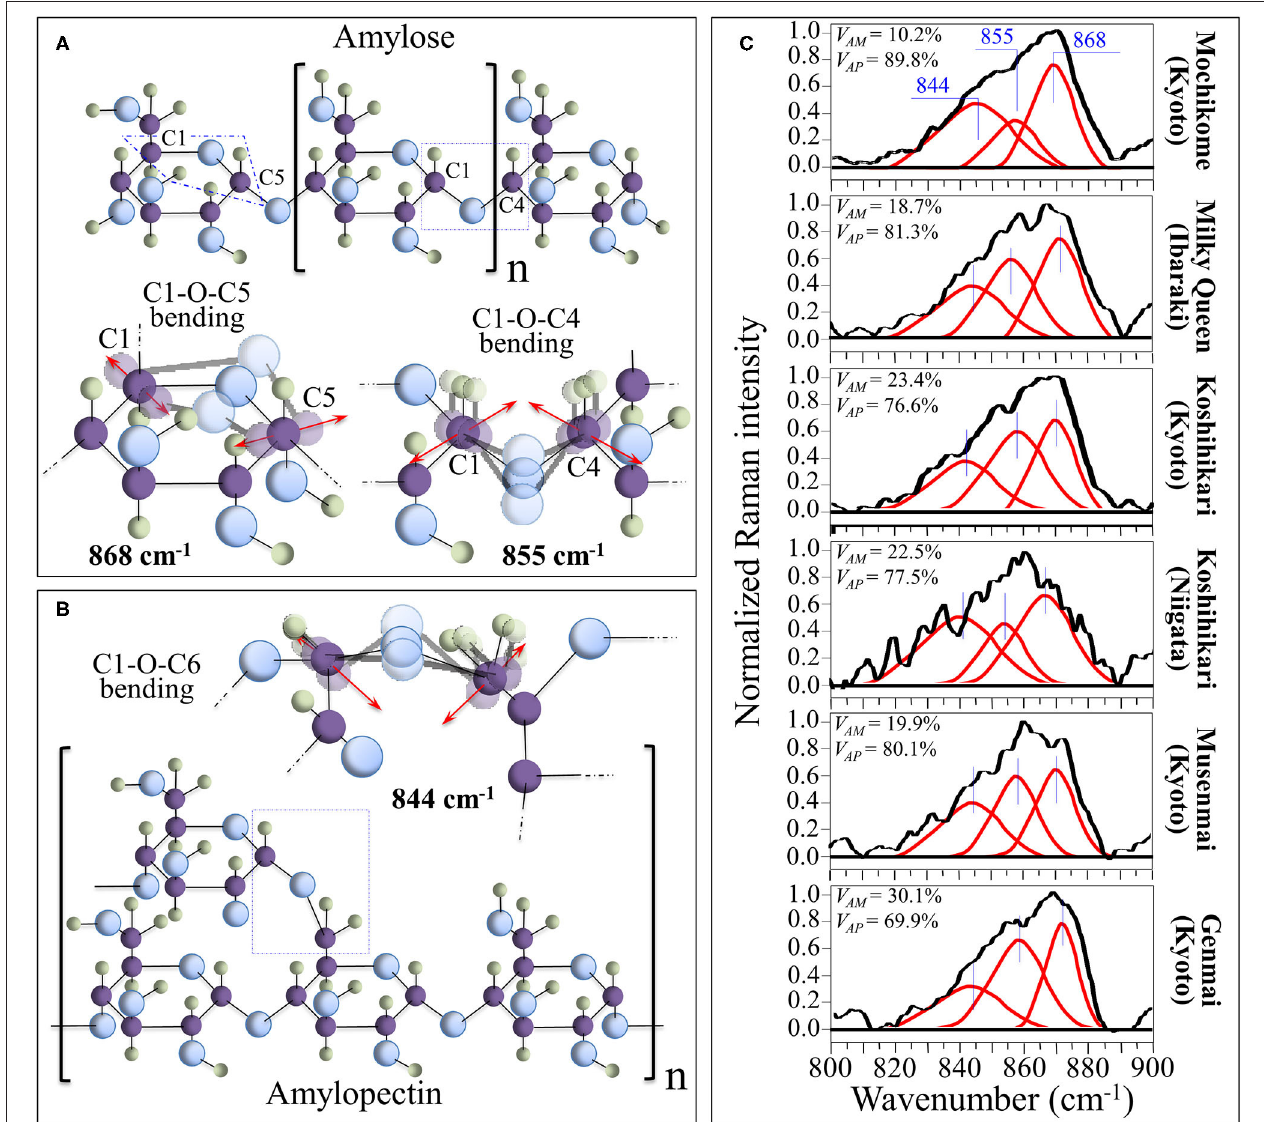
FIGURE 2 | Schematic drafts of amylose (A) and amylopectin (B) structures, presented with emphasis placed on C-O-C bending modes, whose characteristic Raman frequencies are given in inset. In (C) , deconvoluted Raman spectra of different rice cultivars in the spectral region 800–900 cm − 1 are shown (cf. labels) with the calculated volume fractions of amylose and amylopectin given in